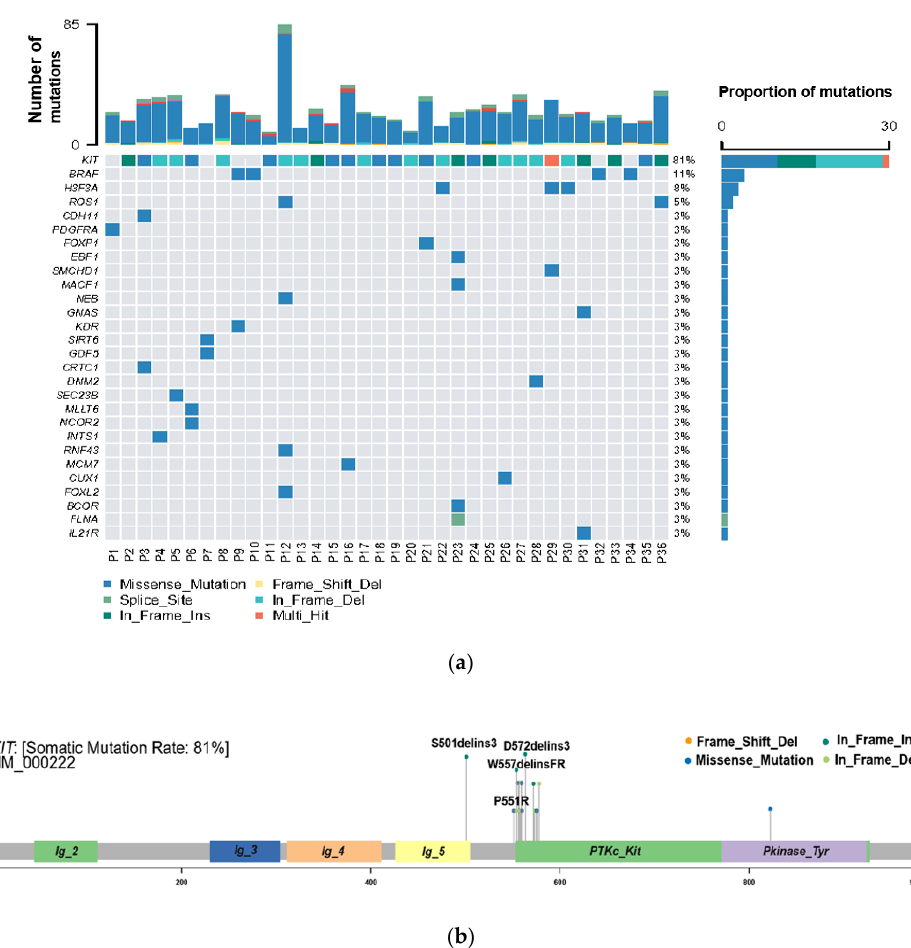
Figure 2. High frequency of oncogenic mutations in 36 small gastrointestinal stromal tumor (GIST) samples identified by whole-exome sequencing (WES). ( a ) Selected driver genes, by comparing so- matic mutations and known driver genes in the database; ( b ) mutation distribution in the KIT mo- lecular structure diagram, with novel mutations marked.